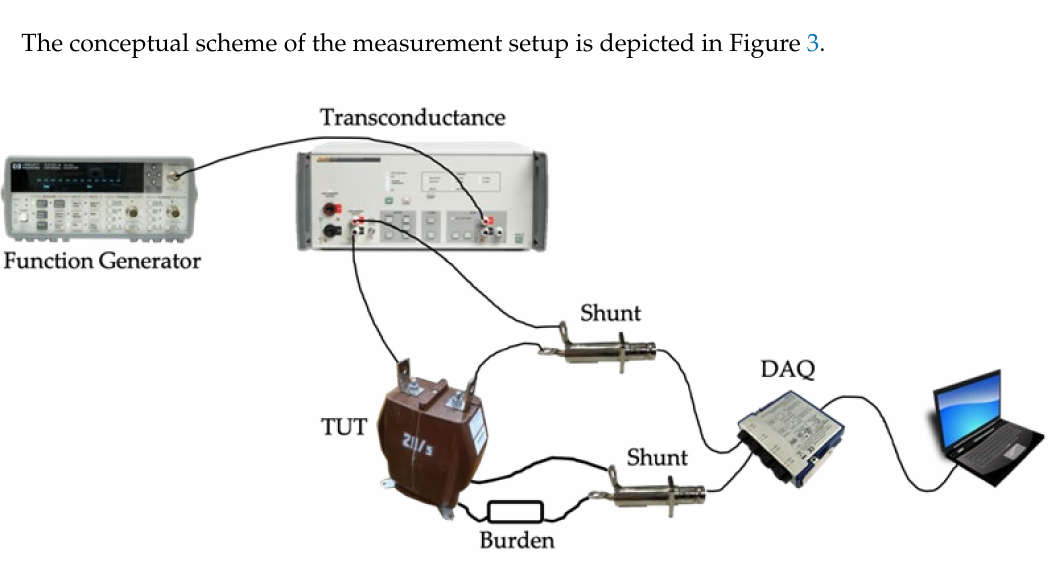
Figure 3. Schematic of the measurement setup used for the